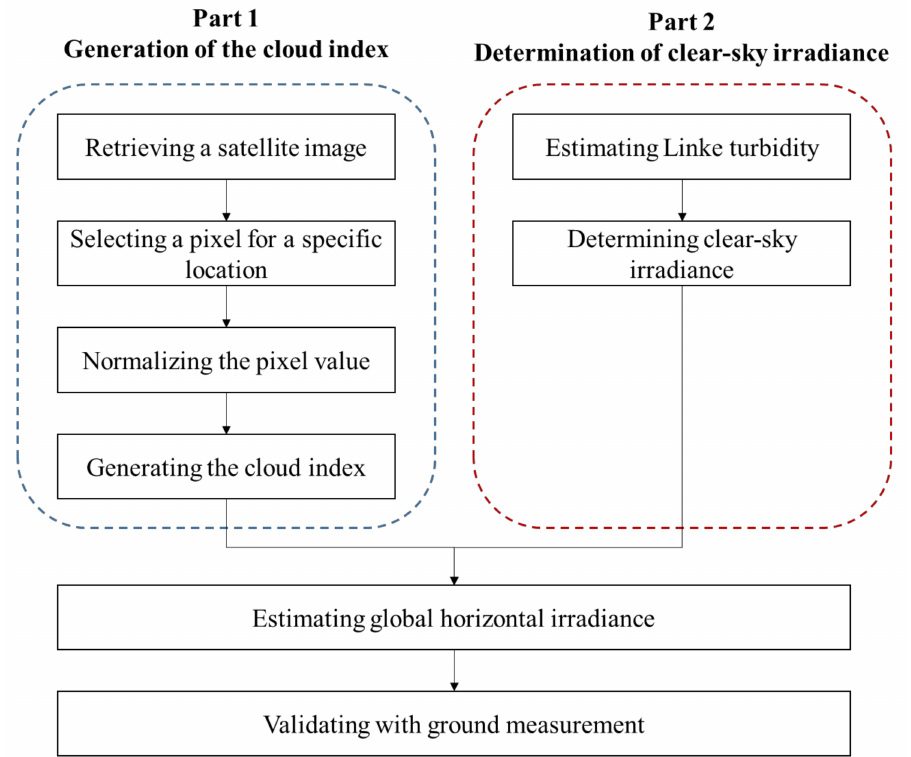
Figure 2. Procedure to derive solar irradiance from satellite